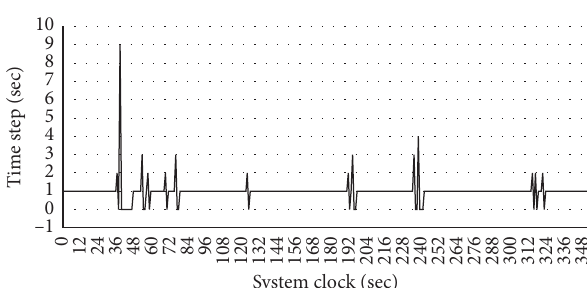
Figure 16: The change in time step Δ t obtained by transition function Φ